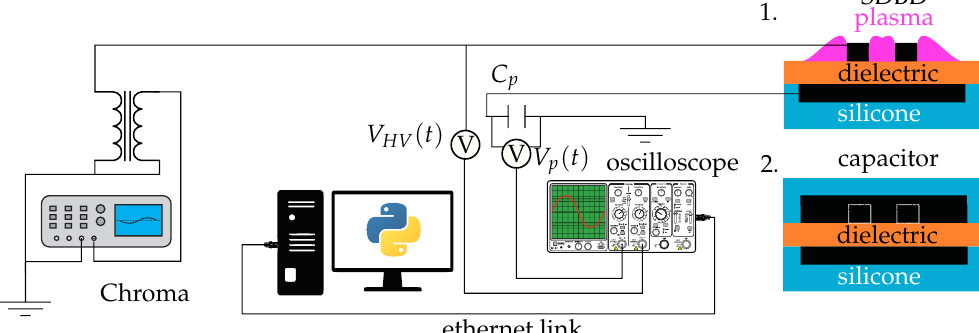
Figure 5. Measurement setup for the plasma power and the estimation of the dielectric losses. Configuration 1 is a sketch of the SDBD sample. Configuration 2 represents the capacitor